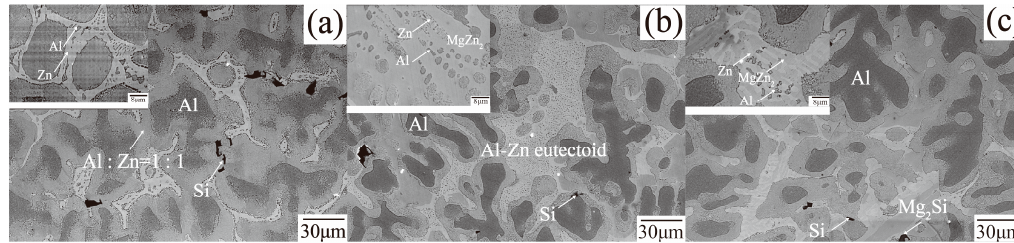
Figure 2. The microstructure of alloy: ( a ) 23AZS, ( b ) 23AZS–1.5Mg, and ( c ) 23AZS–3Mg.